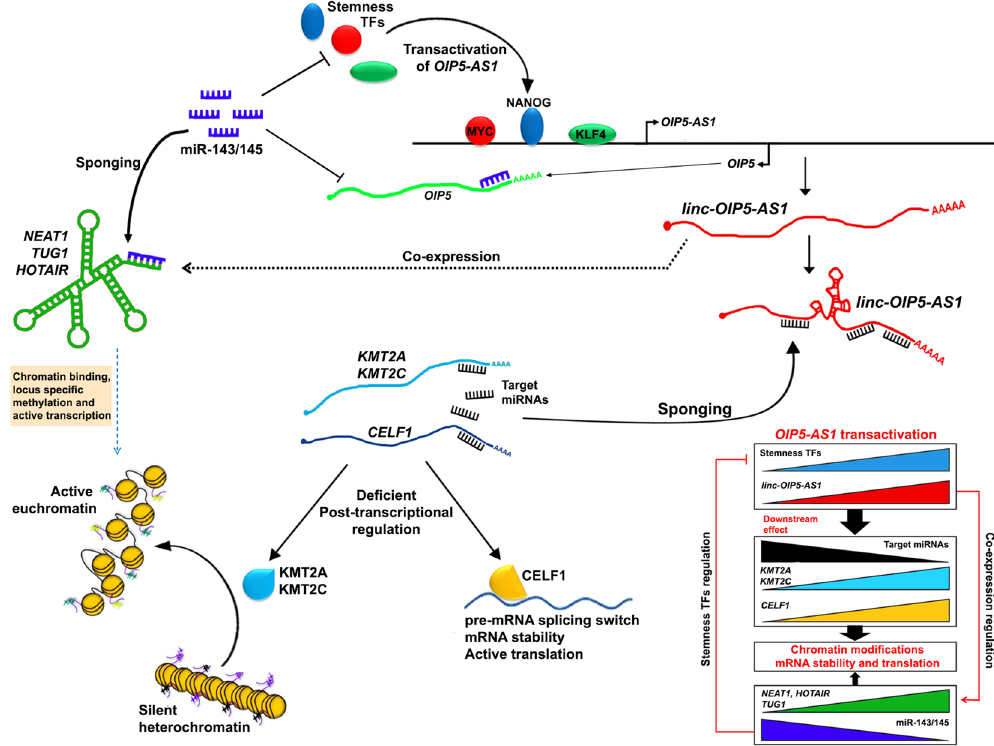
Figure 6. Transactivation of OIP5-AS1 by stemness regulatory TFs and downstream molecular cascade. Stemness associated TFs transactivates OIP5-AS1 by binds to the promoter. The overexpressed OIP5-AS1 sponges the miRNAs targeting KMT2A, KMT2C and CELF1 . With deficient in post-transcriptional regulation, KMT2A, KMT2C and CELF1 overexpress resulting in chromatin modification and increased mRNA